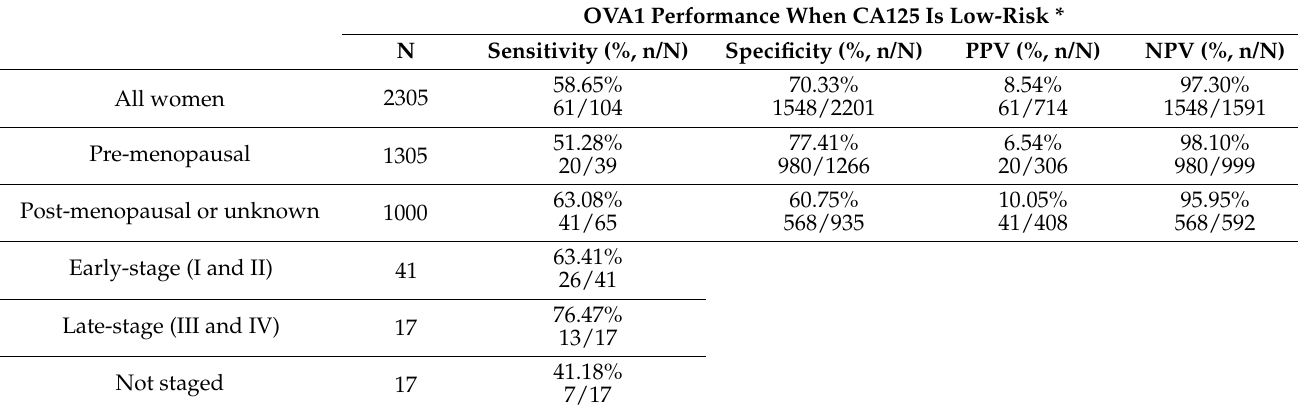
Table 2 summarizes the influence of menopausal status on the performance of OVA1. For premenopausal women with a low-risk CA125 diagnosed with malignancy, the sensi- tivity and specificity of OVA1 were 51% and 77%, respectively. In postmenopausal women, OVA1 salvaged detection in 63% of the cancers which CA125 did not detect. Specificity was 61%, with PPV and NPV of 10% and 96%, respectively. In patients with benign disease on fi- nal pathology, OVA1 was low-risk in 980/1266 premenopausal women (77% specificity, 98% NPV) and 568/935 postmenopausal women (61% specificity, 96% NPV). The false-positive rate for premenopausal women was 23% and 39% for postmenopausal women. Table 2. Clinical performance summary of OVA1 in low-risk CA125 patients. OVA1 Performance When CA125 Is Low-Risk *